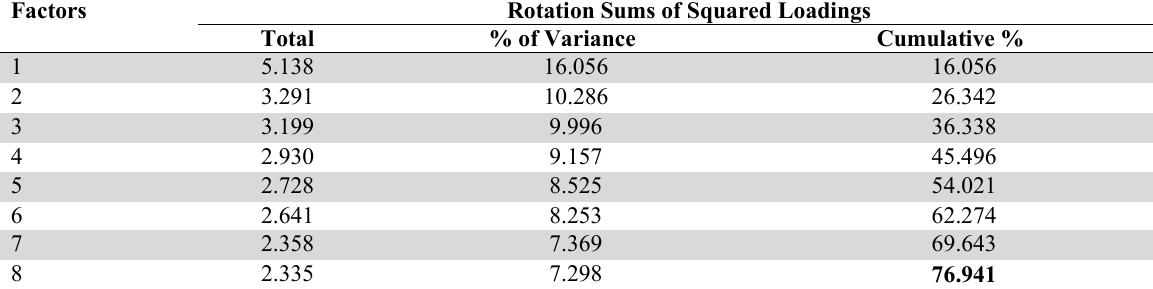
Total variance explained – rotation sum of square loadings